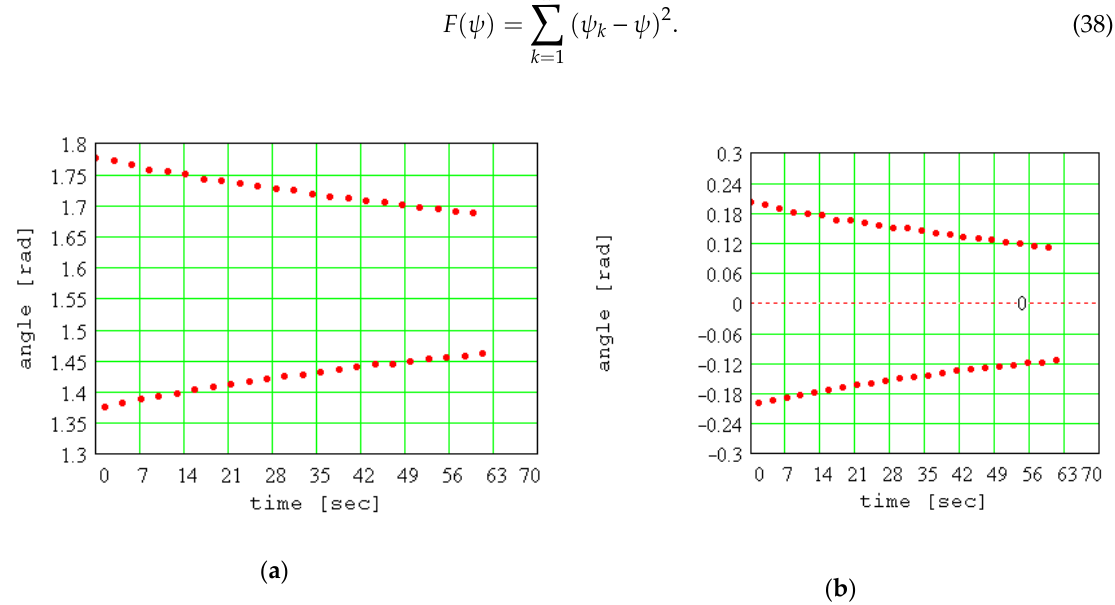
Figure 14. Experimental evidence of the decrease in angular amplitude of the pendulum: ( a ) initial values; ( b ) with respect to the equilibrium